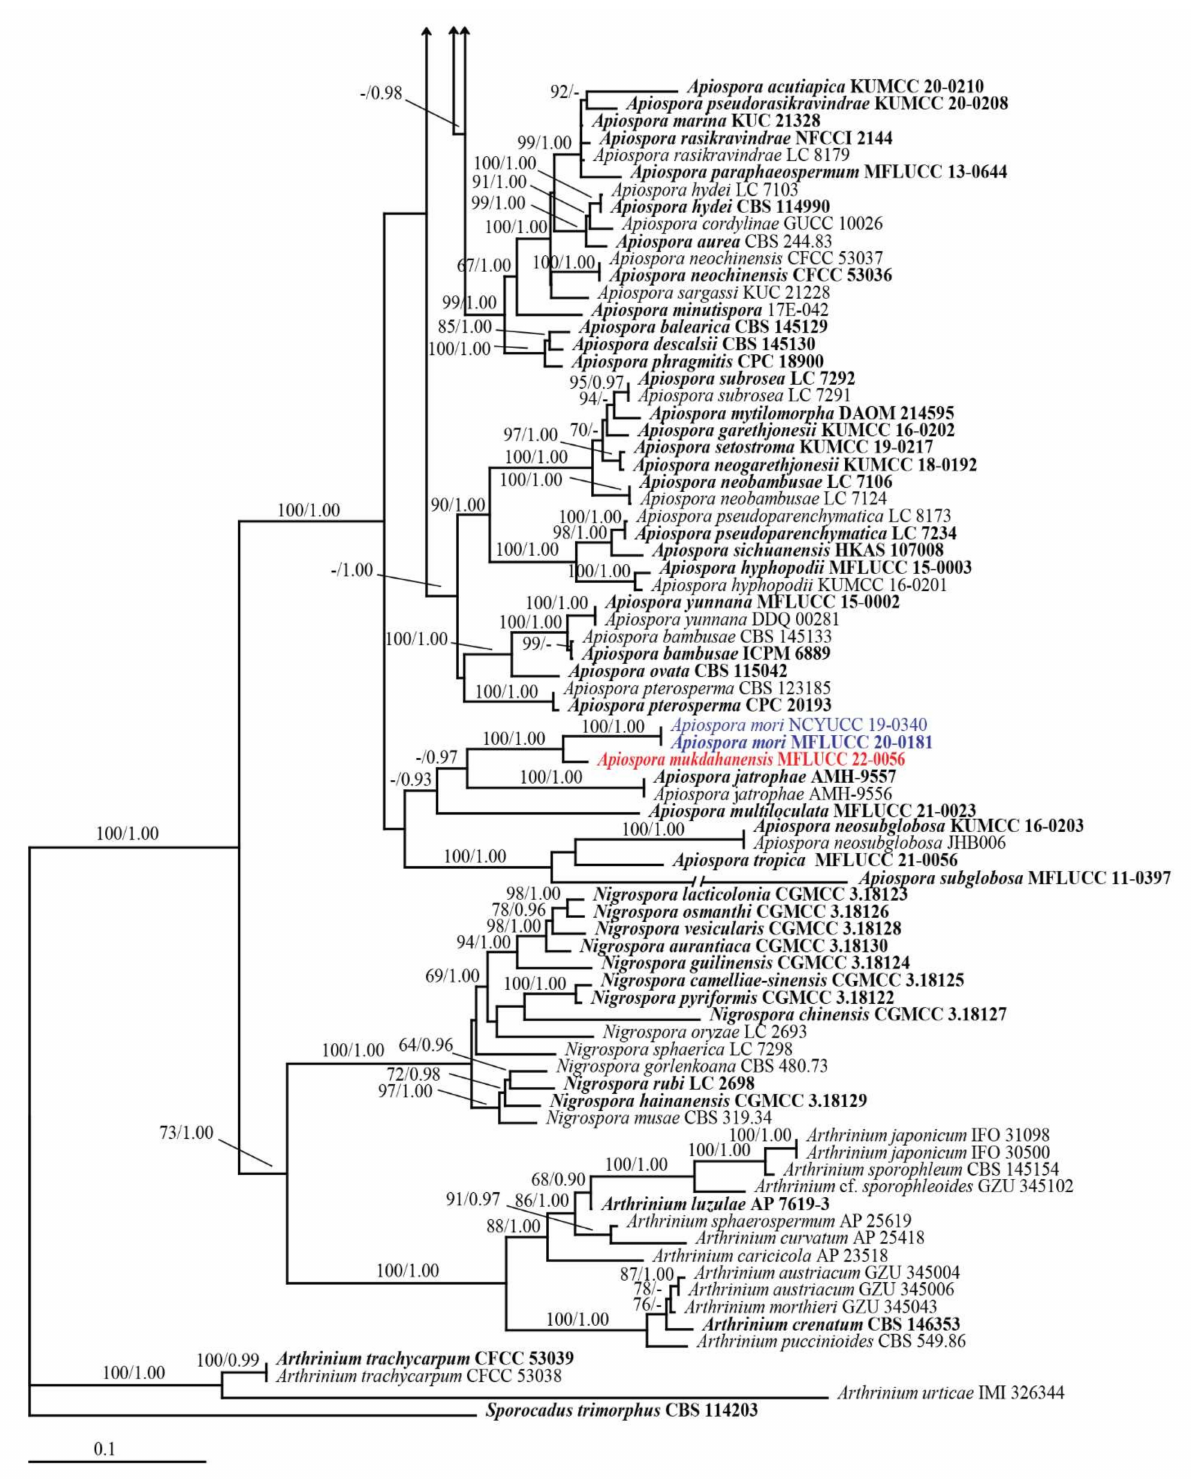
Figure 1. Phylogenetic tree retrieved from RAxML analyses of a combined ITS, LSU, TUB2 , and TEF1- α data sequence of Apiospora , and other related taxa in the family Apiosporaceae . Bootstrap support values for ML equal or greater than 60% and Bayesian posterior probabilities greater than 0.90 are indicated at the nodes as ML/PP. The ex-type strains are in bold. The new species are in red and new record and new combination species are in blue. The tree is rooted to Sporocadus trimorphus (CBS